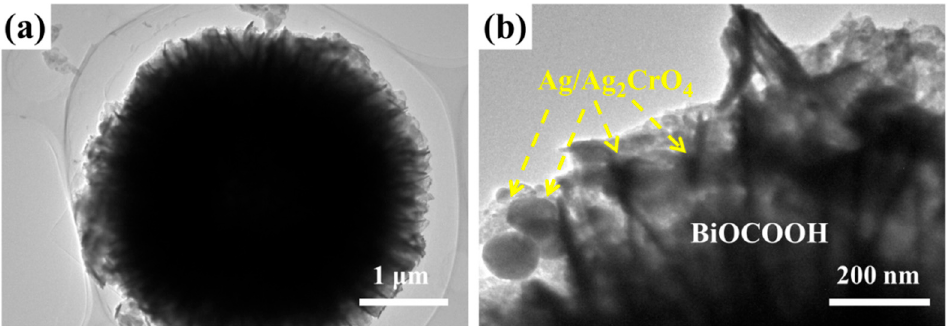
Figure 4. ( a , b ) TEM images of Ag / Ag 2 CrO 4 / BiOCOOH.